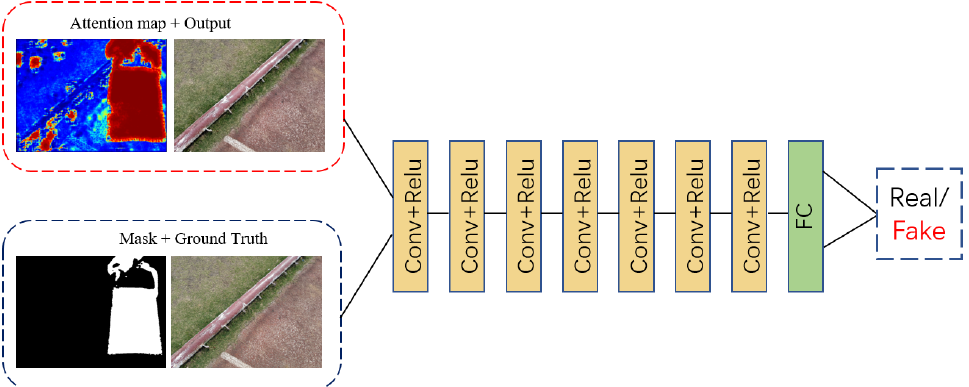
Figure 6. The architecture of the discriminator. The input of the network is the generation con- catenated with attention map or the ground truth concatenated with the mask. The output of the discriminator is 0/1, which means fake or